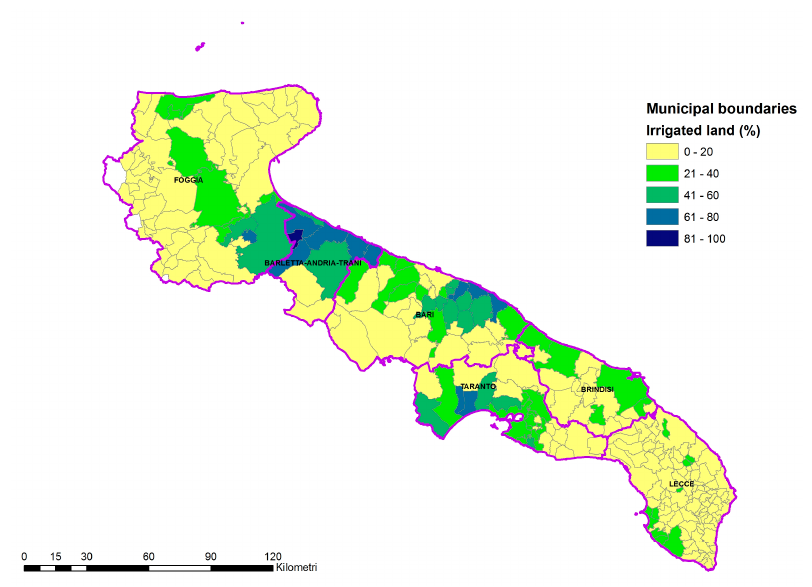
Figure 1. Puglia region with provinces: Irrigated land over utilized agricultural area (2009/2010).